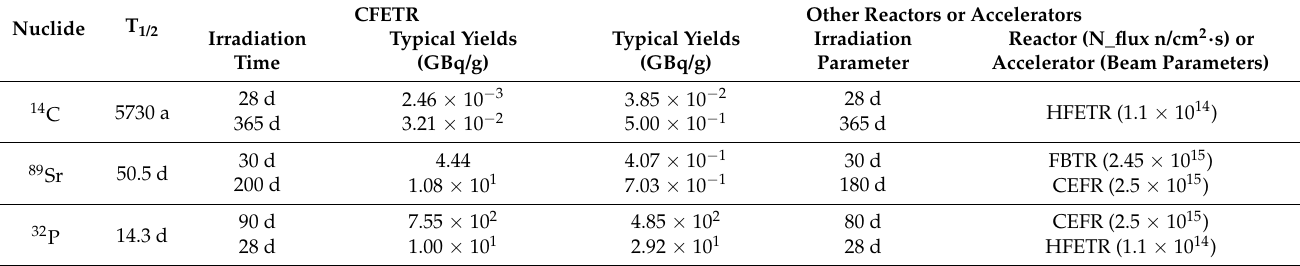
Table 10. Typical yield comparison of CFETR with other types of reactors and